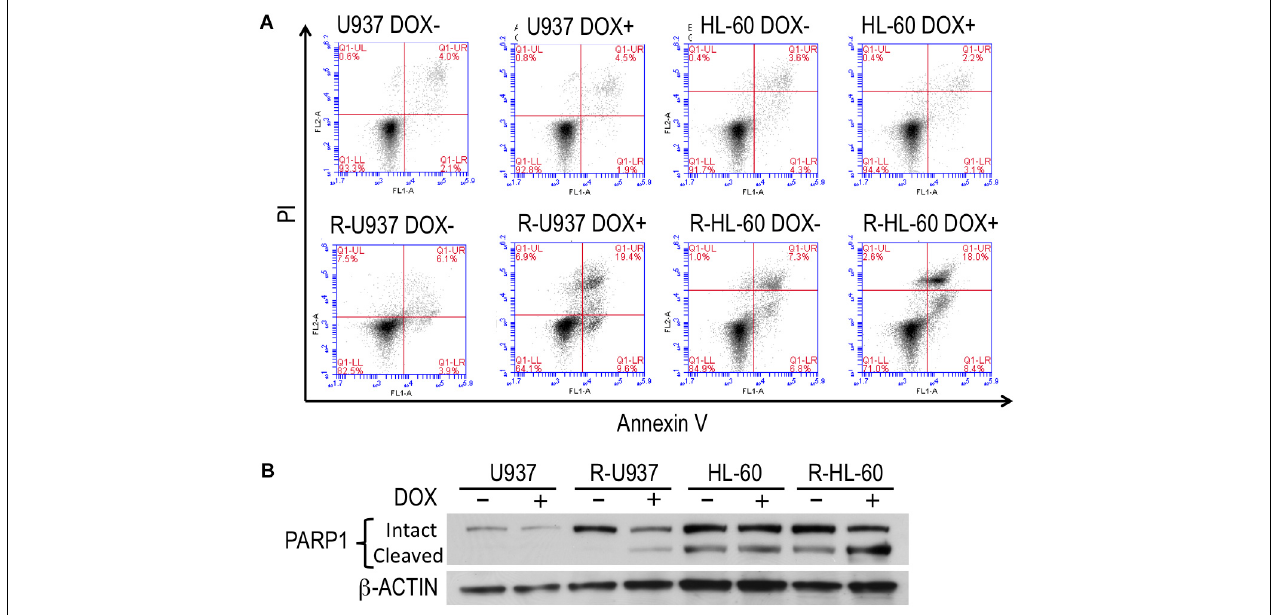
FIGURE 3 | (A) FACS analysis of annexin V/propidium iodide double staining in shHP1 γ -infected cells after incubation with (DOX+) or without (DOX–) 1 µ g/ml doxycycline for 96 h. Typical plots from a representative experiment were shown. The experiments were repeated three times. (B) The PARP1 cleavage profiles in shHP1 γ -infected cells after incubation with (DOX+) or without (DOX–) 1 µ g/ml doxycycline for 96 h.